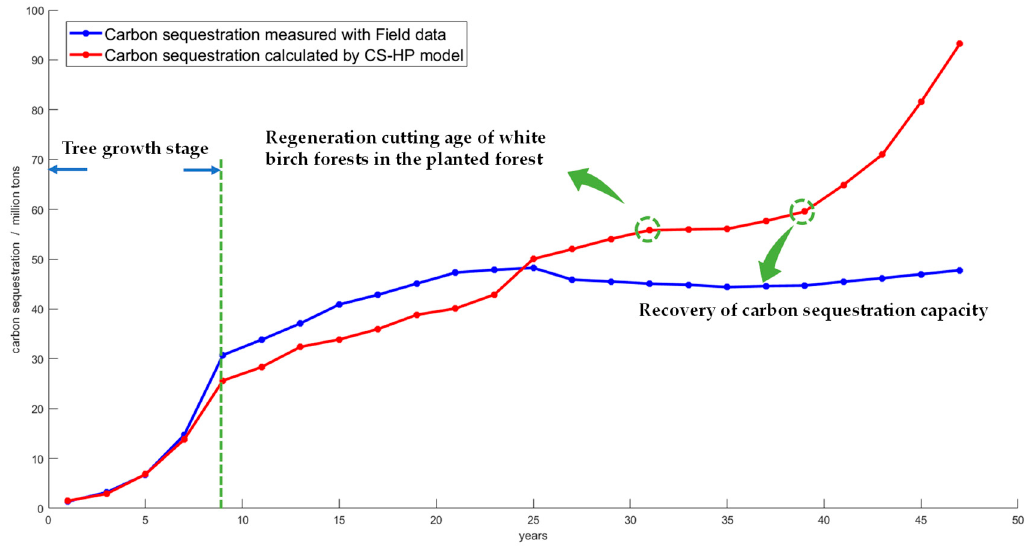
Figure 3. Comparison chart of forest carbon dioxide absorption (considering only carbon sequestration).